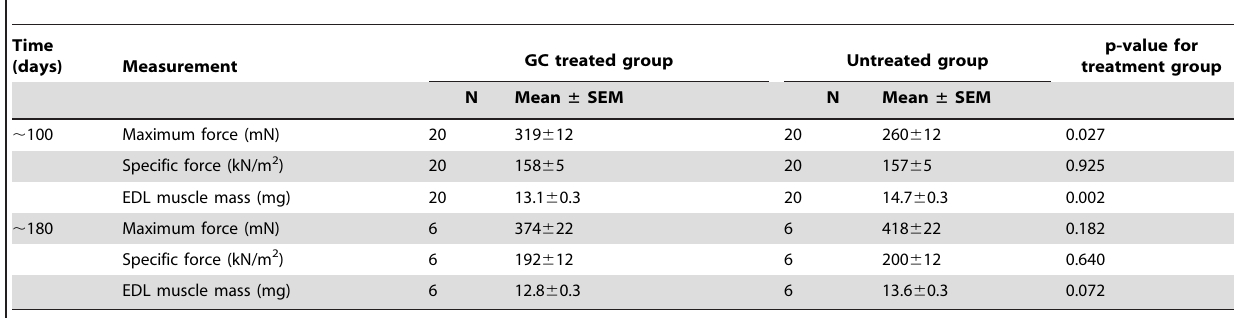
Table 3 . Muscle force at 100 and 180 days in untreated and GC-treated